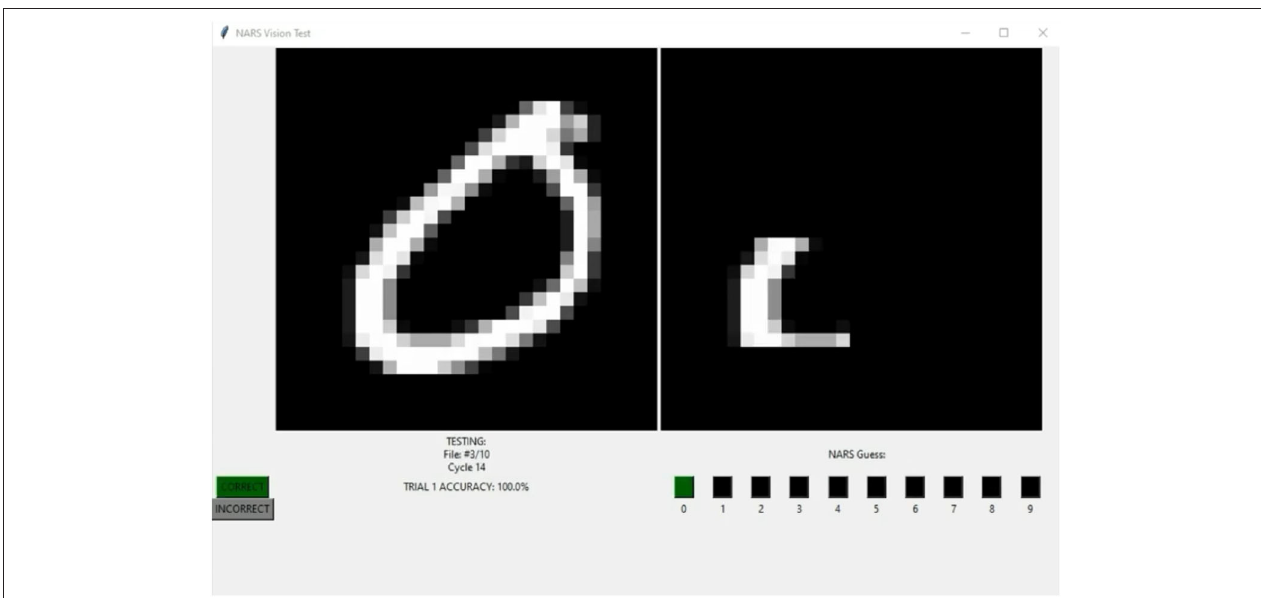
FIGURE 1 | In this screenshot, NARS executes an operation indicating it recognizes an image of digit zero. The videos documenting the trials in the table are available on YouTube (Binary Memorization; Digit Memorization; Binary Classification; Digit